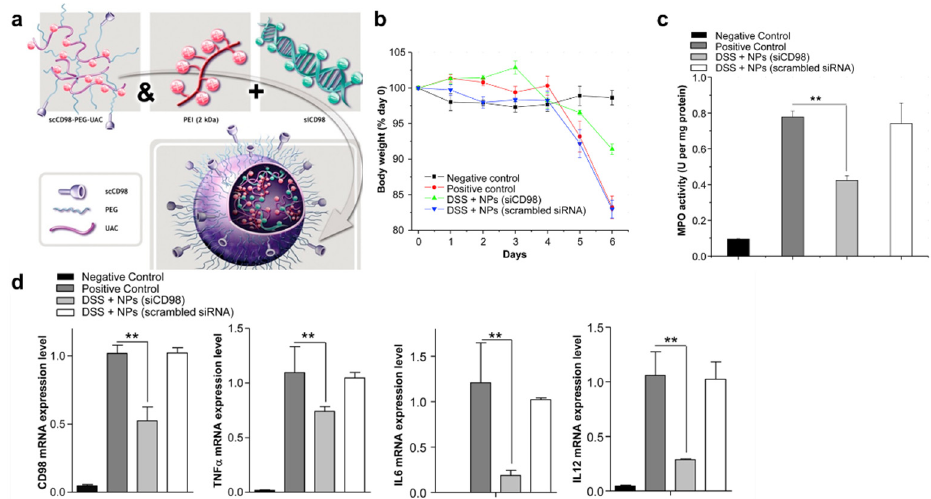
Figure 3. Oral CD98 siRNA-loaded nanotherapeutics decrease the severity of colitis in mice. ( a ): Schematic representation of the self-assembly of single-chain CD98 antibody-functionalized siRNA-loaded nanoparticles. ( b ): Body weight in DSS-induced colitis mice. ( c ): Colonic Myeloperoxidase (MPO) activity. ( d ): The mRNA levels of CD98 and proinflammatory cytokines in mice by treatment. Statistical p -values: ** p < 0.01. Reproduced with permission [77]. 2014, Elsevier.